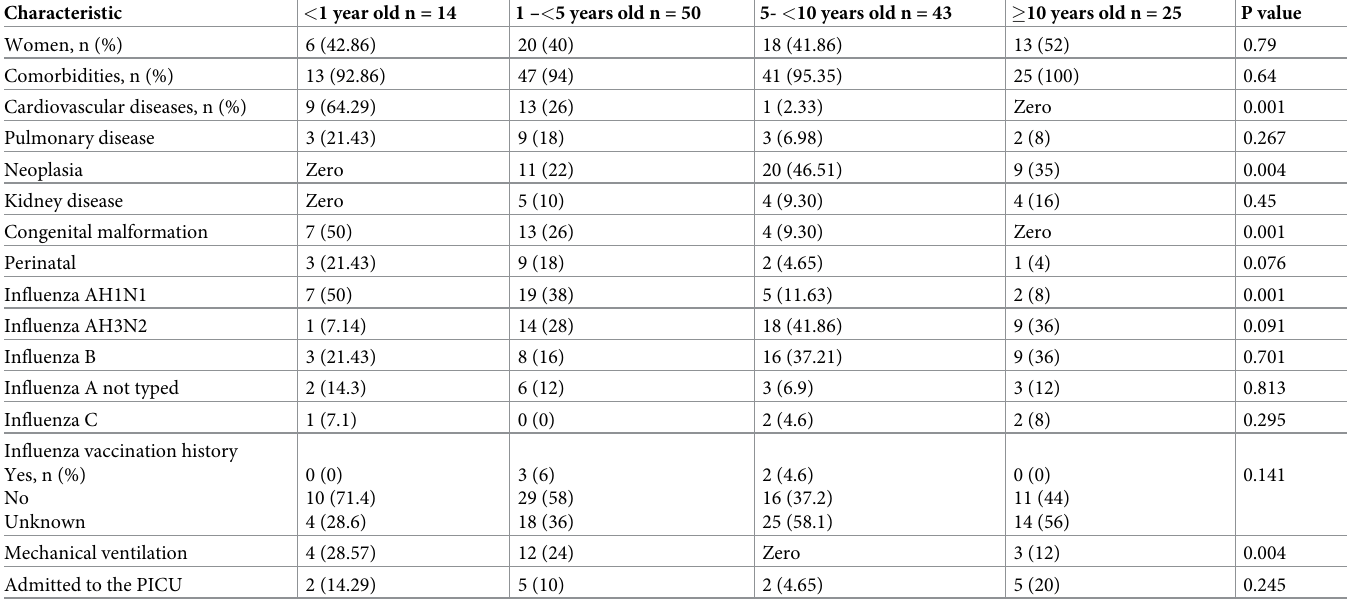
Table 1. General patient